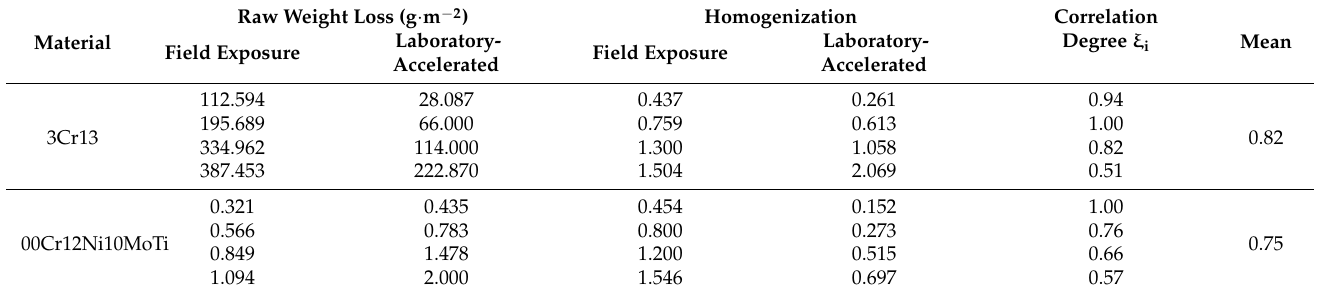
Table 7. Grey correlation between laboratory-accelerated and field exposure